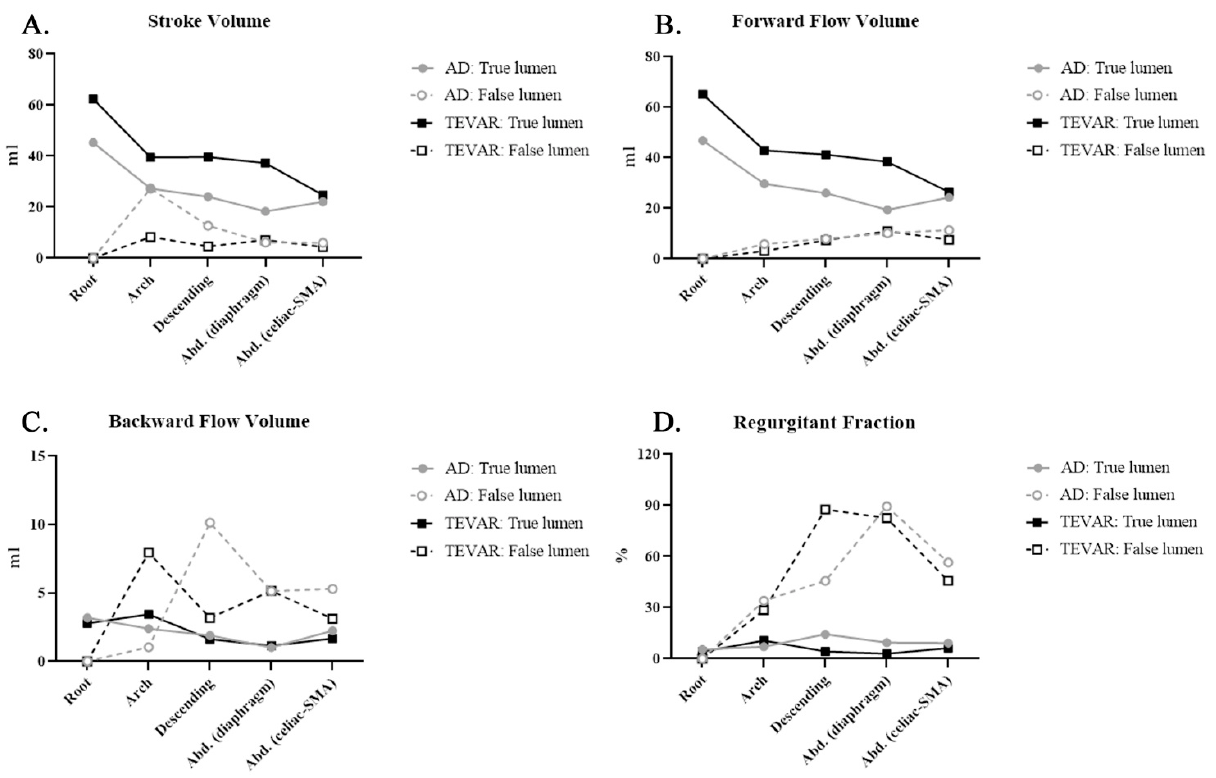
Figure 2. Phase-contrast magnetic resonance imaging (PC-MRI) quantitative flow measurements after thoracic endovascular aortic repair (TEVAR) compared with those before TEVAR ( A ) stroke volume (SV): SV decreased in the false lumen and increased in the true lumen after TEVAR; ( B ) forward flow volume (FFV): FFV increased in the true lumen; ( C ) backward flow volume; ( D ) regurgitant fraction (RF): RF in the aortic arch increased in the false lumen and decreased in the true lumen.